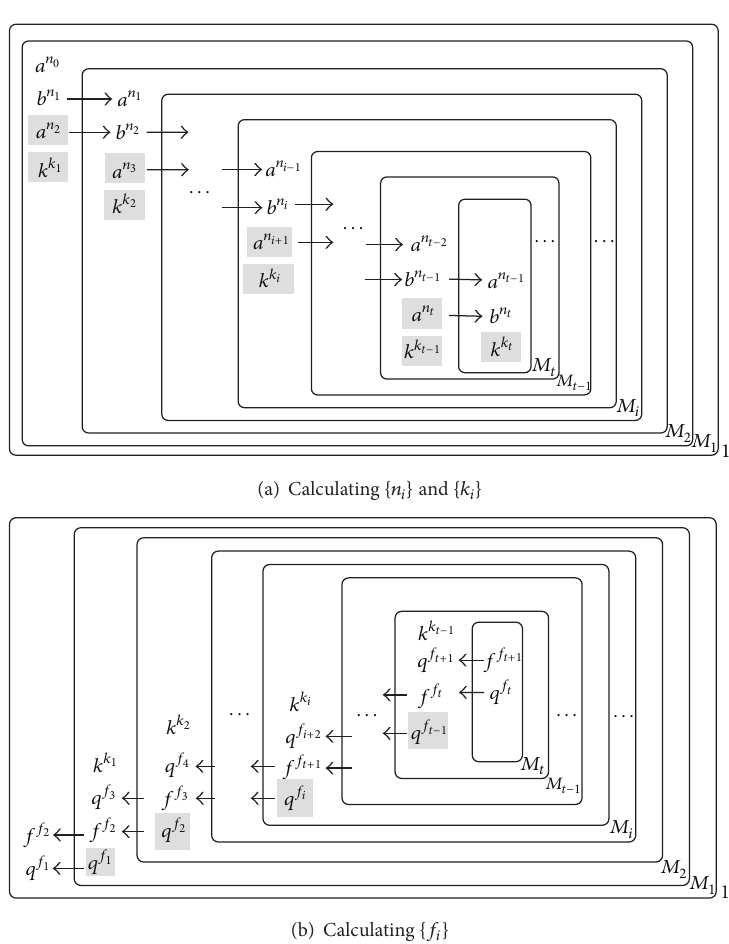
Figure 2: Schematic diagrams for the algorithm in Section 3.2 being implemented by the P